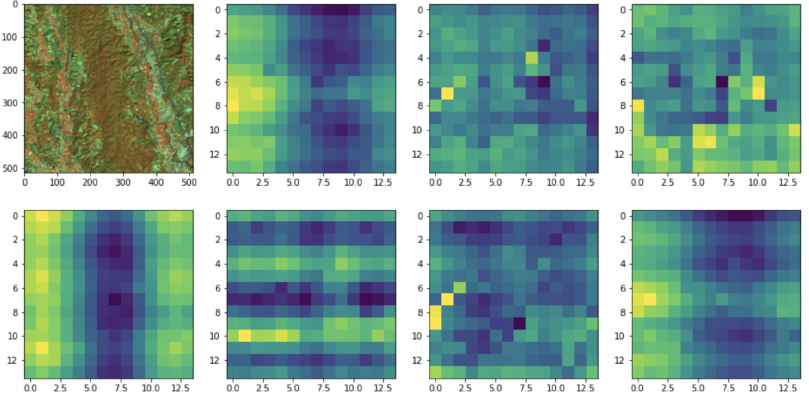
Figure 3. The visualization of attention: each cell reveals the cosine similarity between its embedding and other pairwise